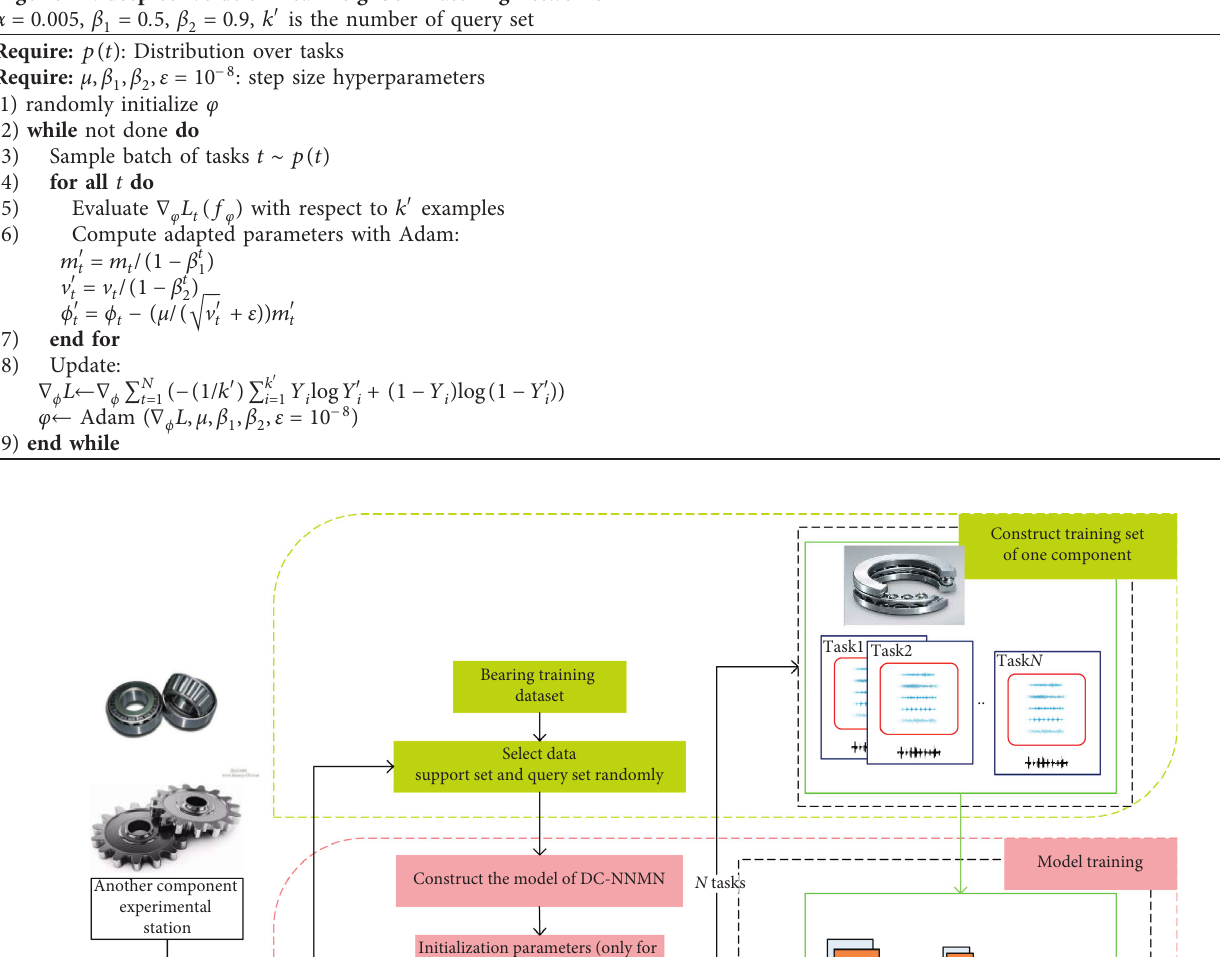
Algorithm: deep convolution near neighbor matching